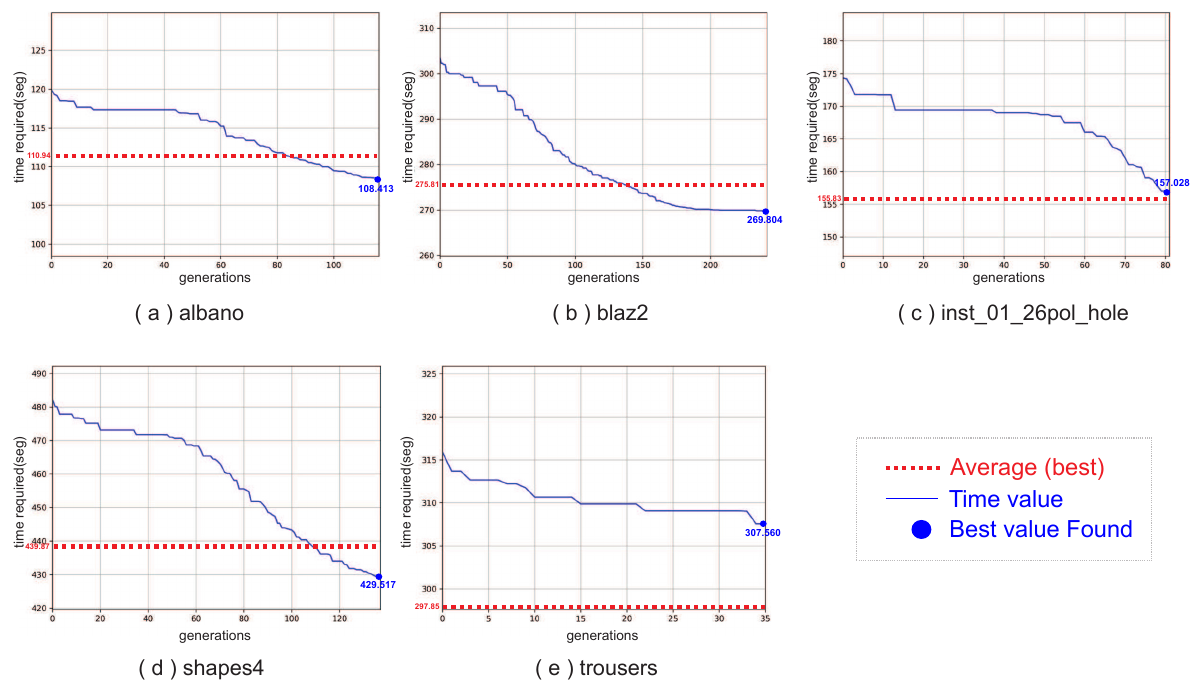
Figure 15. Evolution process defined for time limit reached instances in C-group. Configuration of BRKGA: [P = 5000, P e = 0.30, and P m =